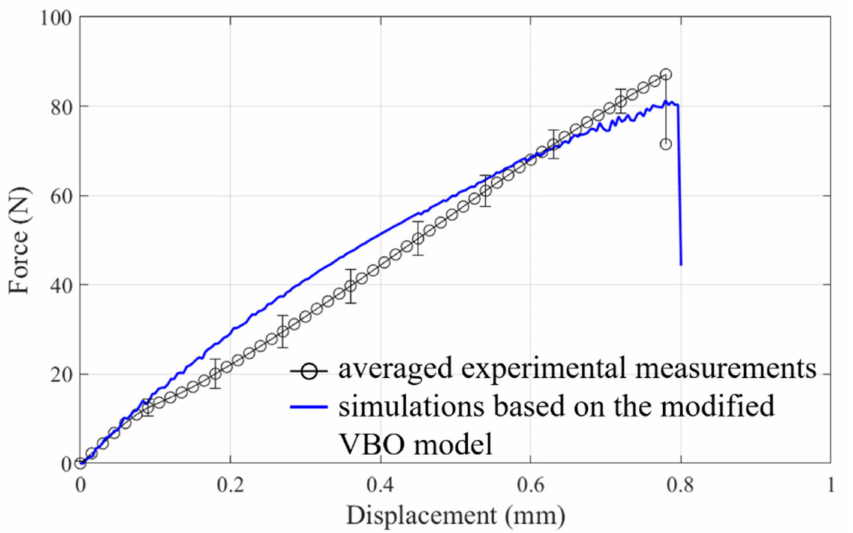
Figure 12. Force-displacement responses of the latch of DDR4 connector based on the experiments and